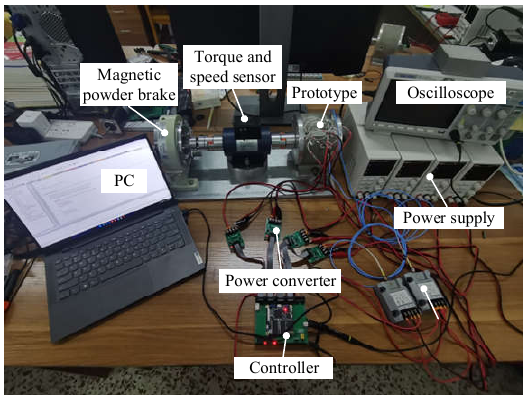
Figure 7. Experiment test platform. Table 2. Main measuring equipment.